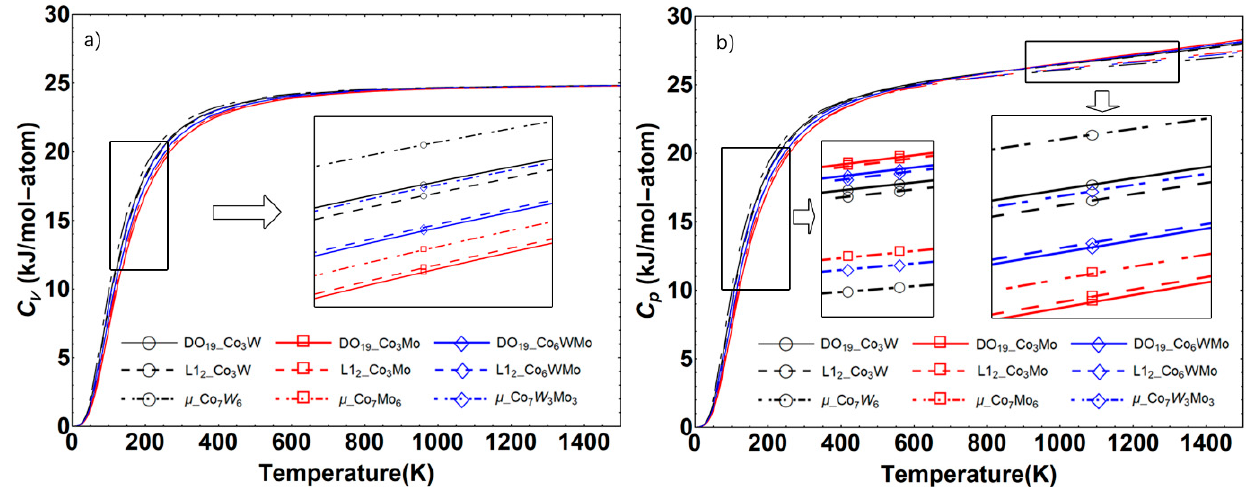
Figure 3. ( a ) Isochoric heat capacity ( C v ) and ( b ) isobaric heat capacity ( C p ) of the Co–W/Mo compounds in the DO 19 , L1 2 and µ structures as a function of temperature.